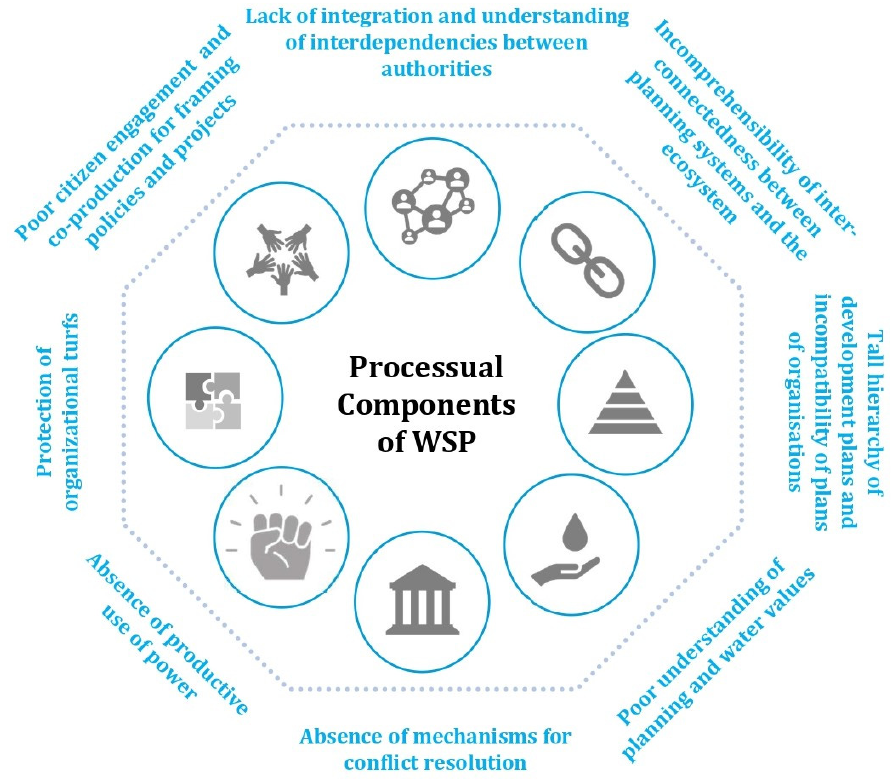
Figure 4. Processual Components of Water Sensitive Planning. Note: A separate paper is being written which is entirely focused on the processual components of the WSP.